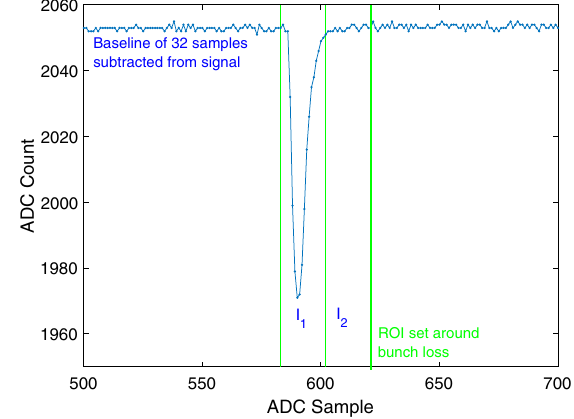
FIG. 4. Photomultiplier signal showing a beam loss of the electron bunch (bunch 1) in the Aramis line. The green lines indicate the borders of the regions-of-interest applied to distin- guish the losses from bunch 1 and bunch 2. I 1 and I 2 are the sums of the baseline-subtracted samples within the two regions of interest.